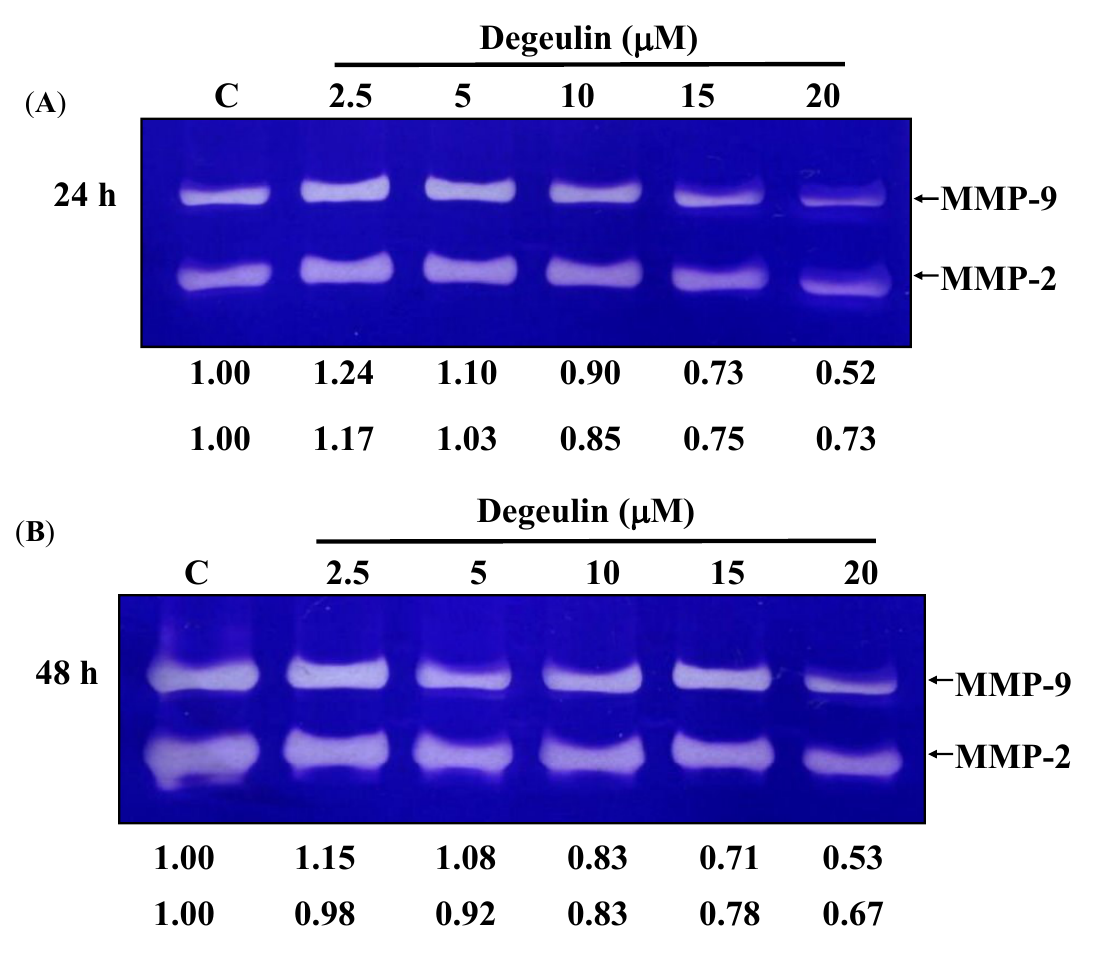
Figure 5. Deguelin affects the activities of MMP-2 and -9 activities in U-2 OS cells. U-2 OS cells (5 × 10 4 cells/well) were incubated with 0, 2.5, 5, 10, 15 and 20 μM of deguelin for 24 ( A ) and 48 h ( B ) then to detect the activity of secreted MMP-2 and MMP-9 using conditioned medium from U-2 OS cells. The different activity of MMP-2 and MMP-9 were determined by densitometric analysis and results are expressed as a percentage of the control